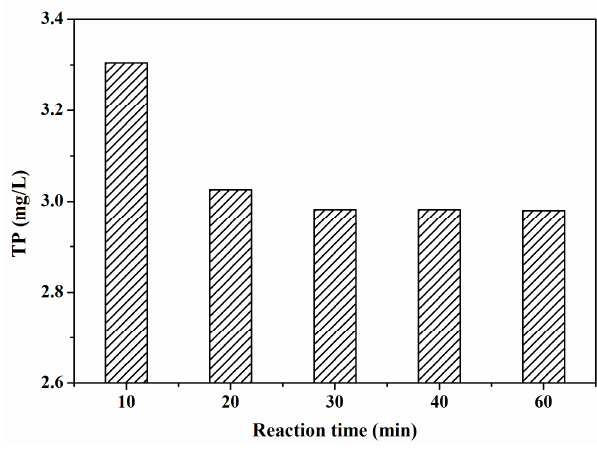
Figure 2. Effect of reaction time on TP removal. Figure 2. E ff ect of reaction time on TP